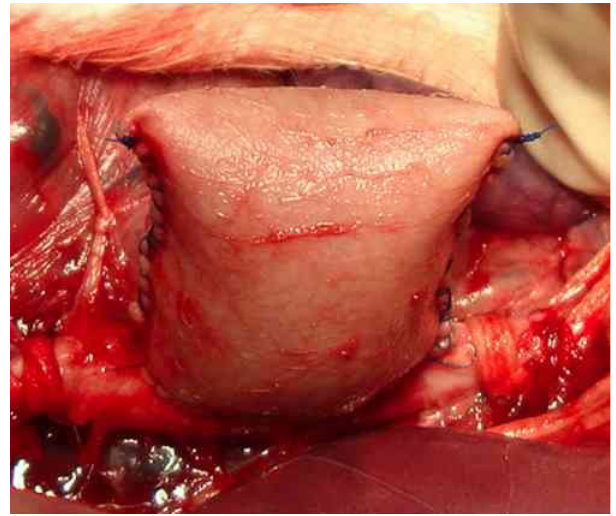
Fig. 2 – Saccular aneurysm after restoring blood